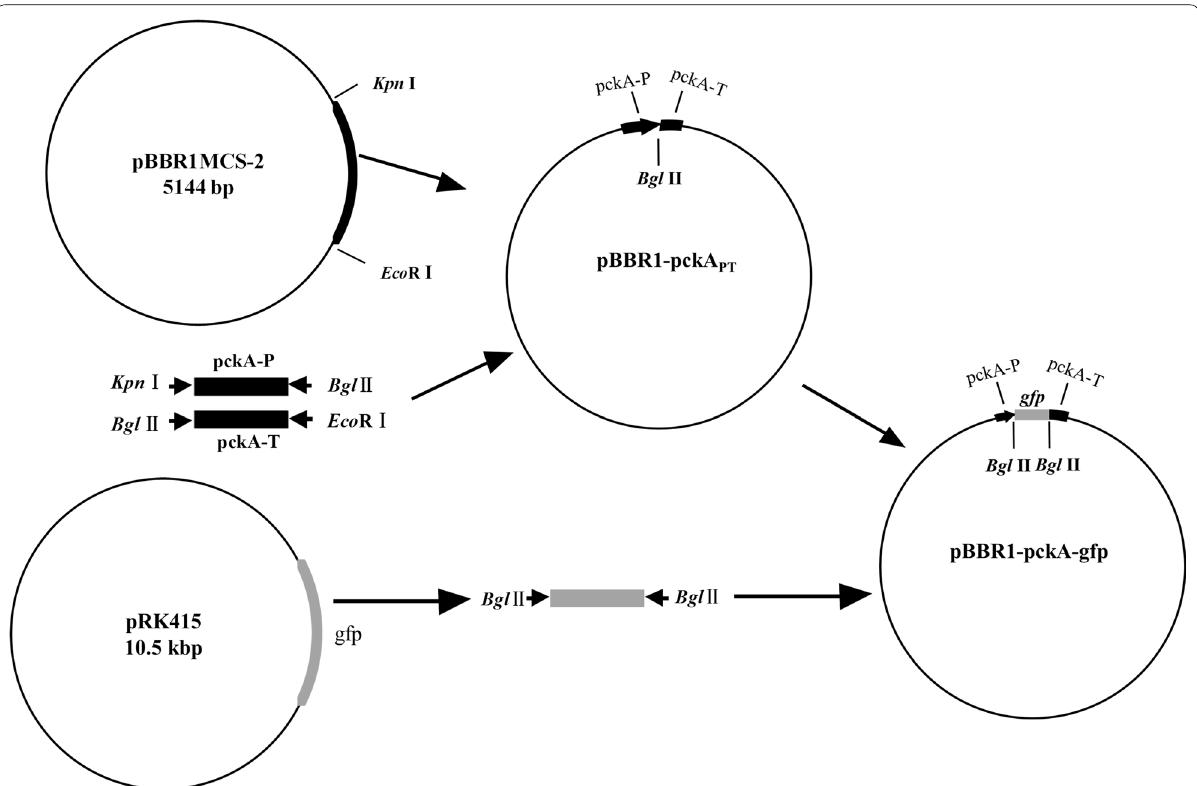
Fig. 1 Construction of gfp-tagged plasmid. Plasmid pBBR1MCS-2 was used as cloning vector to express GFP under the control of pckA promoter of Rhodopseudomonas palustris. Restriction sites were shown in “Materials and methods”. The pckA-P and pckA-T were amplificated from the R. palustris GJ-22, they were constructed with GFP protein as the promoter and terminator to express green fluorescent protein in R. palustris